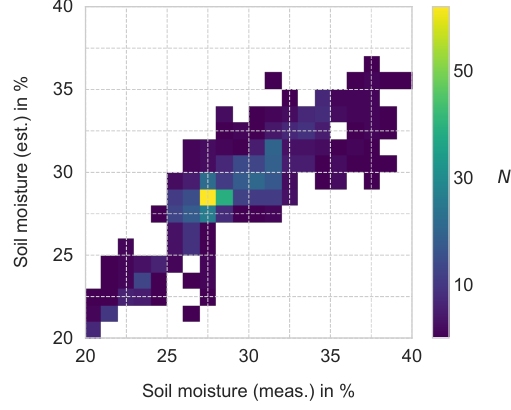
Figure 2. Schematic representation of the regression framework. * The PCA is applied only on the hyperspectral and LWIR data.